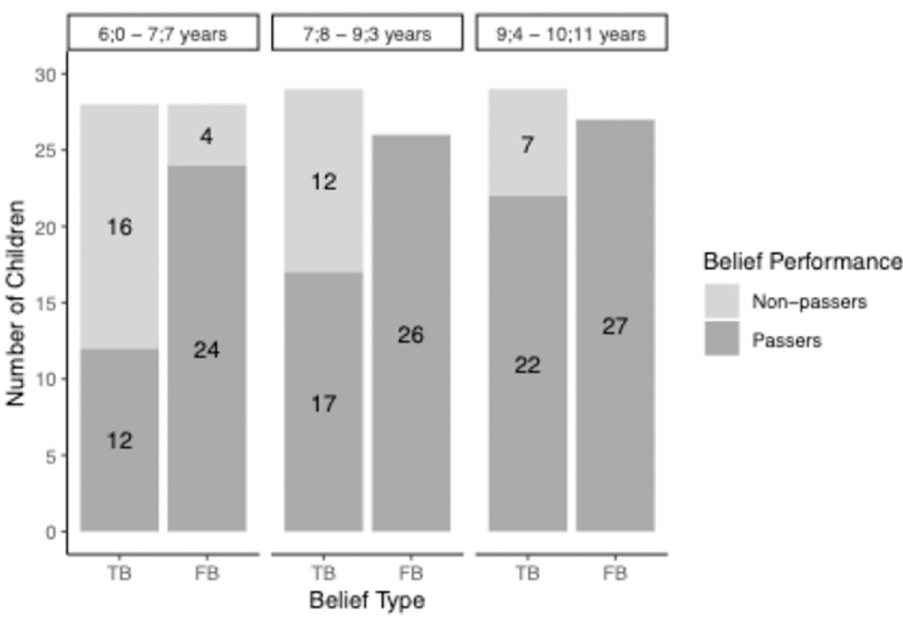
Fig 5. Children’s performance in the change-of-location task as a function of belief type and age in Study 2. Note . Sample size of the groups vary as only children were included who answered the respective control questions correctly. https://doi.org/10.1371/journal.pone.0266959.g005 not be computed for the two older age groups due to ceiling effects in the FB condition (7;8– 9;3-years-olds and 9;4–10;11-year-olds: M = 1). In contrast, Wilcoxon signed rank tests revealed that in the TB condition, only the oldest age group of children (9;4–10;11-year-olds) performed significantly above chance ( M = .76, p < .01, r = -.51). Younger children (6;0– 7;7-year-olds and 7;8–9;3-year-olds) performed at chance level (6;0–7;7-year-olds: M = .43, p = .46, r = -.14, 7;8–9;3-year-olds: M = .59, p = .36, r = -0.17). The correlation between the TB and FB performance in the change-of-location task is (not- significantly) negative for the whole sample ( r (phi) = -.19, p = .10) and significantly negative for the youngest age group (6;0–7;7-year-olds: r (phi) = -.47, p = .02). Because of the ceiling effects in the FB condition, the correlation is not computable for the two older age groups. Main analyses: Predictors for TB performance. Descriptive statistics . The mean perfor- mances in the recursive ToM understanding task, the recursive ToM production task and the syntactic recursion task as a function of TB performance (passers vs. non-passers) and age (young, middle, old age group) are summarized in Table 5. Table 5. Mean performance (M) and standard deviations (SD) in Recursive ToM Understanding (RToM U), Recursive ToM Production (RToM P) and understand- ing of syntactic recursion (Syntact Recurs.) for TB non-passers and TB passers in three groups of age. n Synt. Recurs. RToM P RToM U M ( SD ) M ( SD